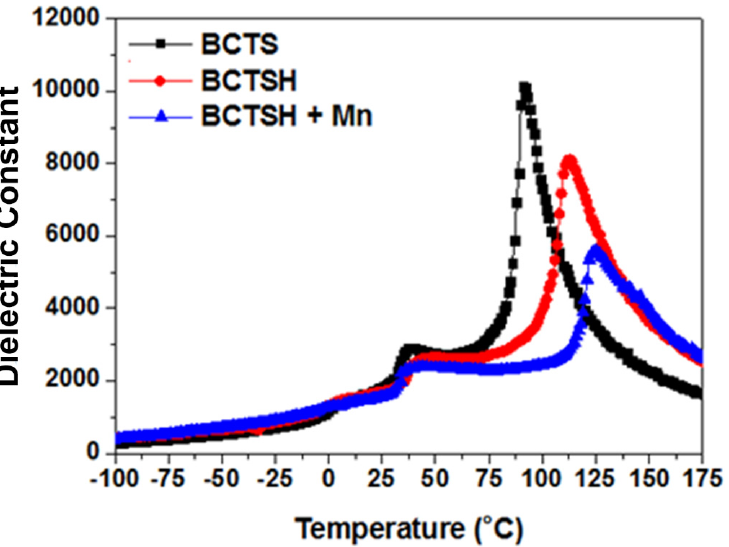
Figure 4. Temperature dependence of the dielectric constant at a measurement frequency 100 kHz for BCTS, BCTSH and Mn − doped BCTSH ceramics.